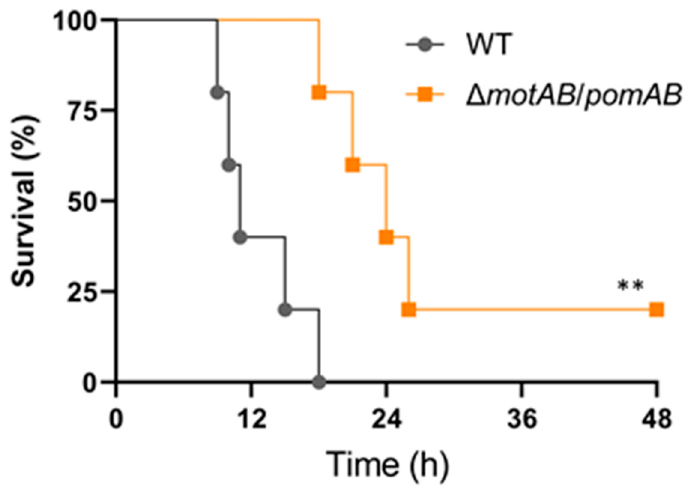
Figure 5. Motility-dependent lethality in the A. hydrophila infection model. Kaplan–Meier survival curves for mice inoculated s.c. with WT and Δ motAB / pomAB and monitored for 72 h. Each symbol represents an individual mouse ( n = 6/group). **, p < 0.01; log-rank test.